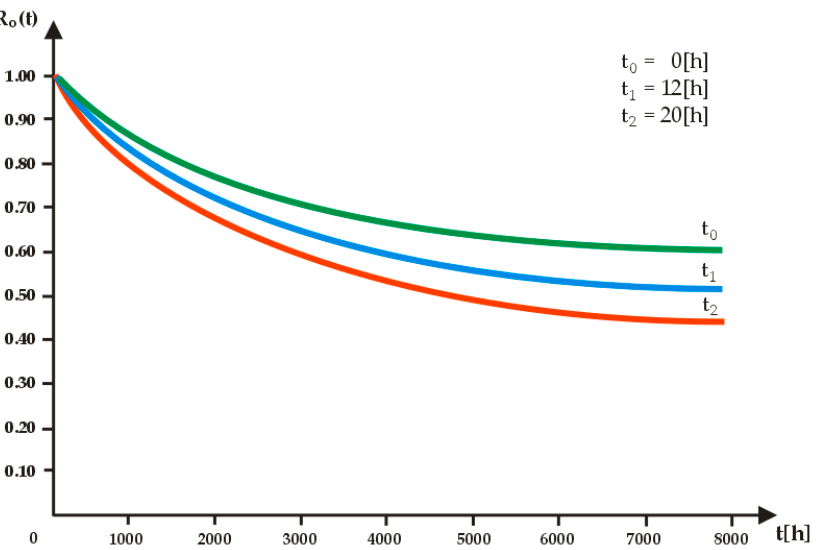
Figure 7. Own study: graph showing changes in the likelihood that the WFD system’s evaluated value will continue to be in the condition of full fitness S1 over time.